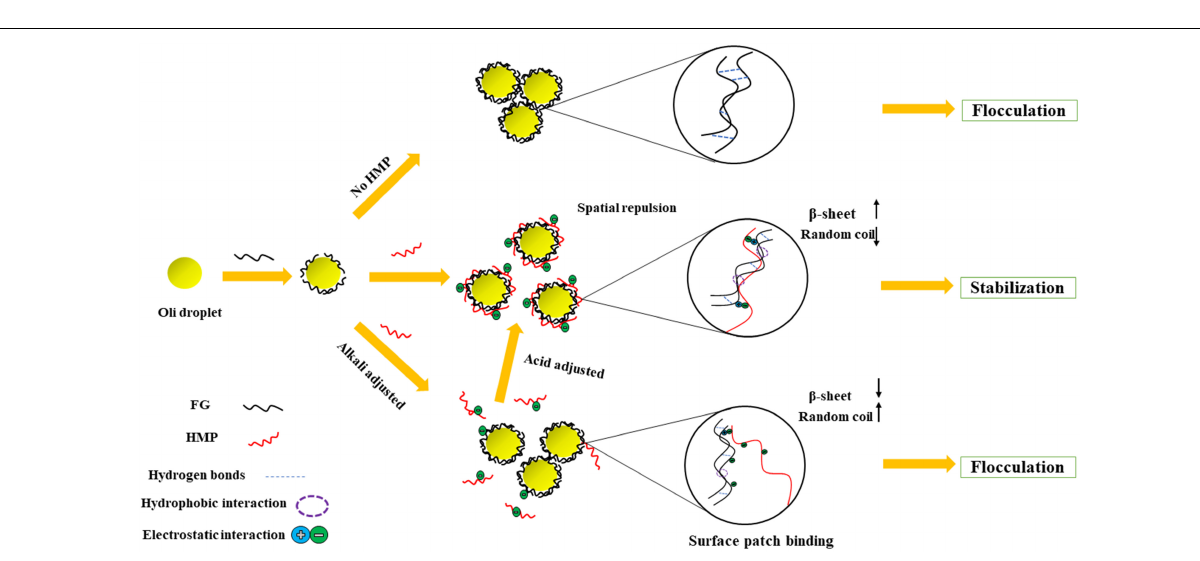
FIGURE 7 | Schematic mechanism of FG-pectin complex